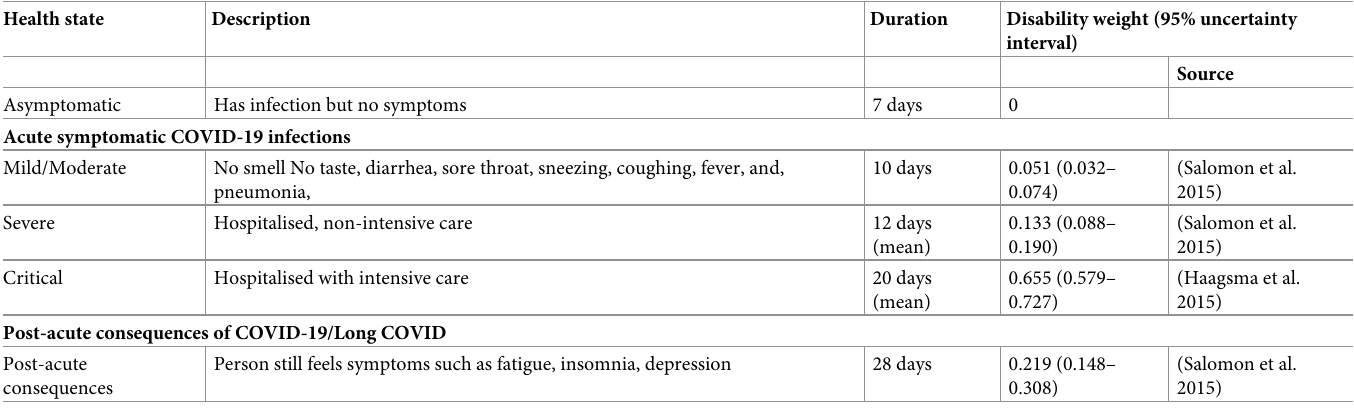
Table 1. Health states, durations and disability weights for estimating the burden of COVD-19 in France